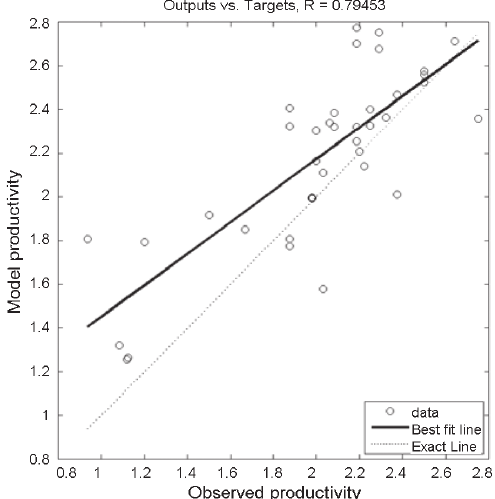
Fig. 6. A scatter plot of baseline model